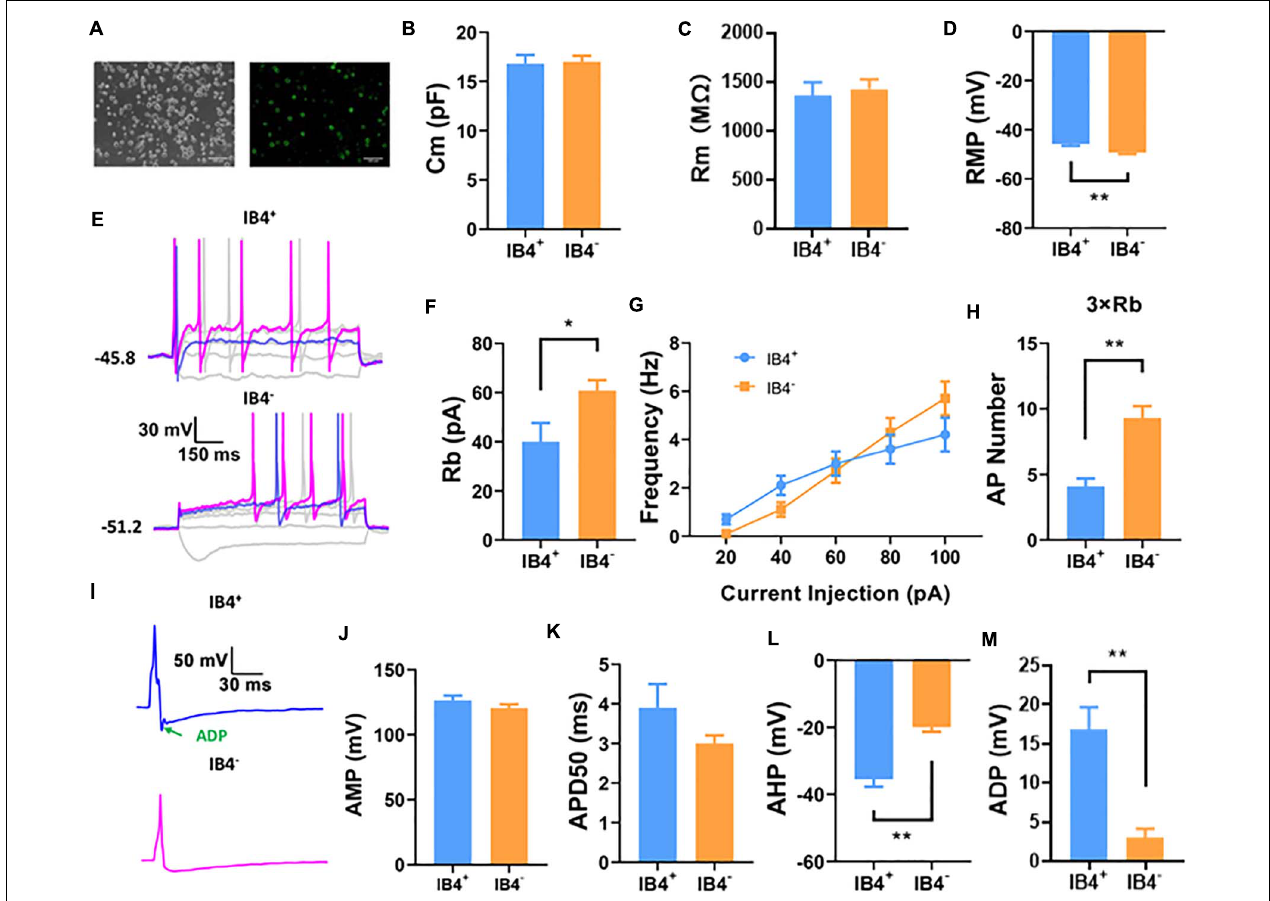
FIGURE 1 | Comparison of passive and active properties of IB4 + and IB4 − subpopulations of small DRG neurons in mouse. IB4 + and IB4 − subpopulations of small DRG neurons ( < 25 µ m), separated by the staining of IB4-FITC (A) . Small DRG neurons were recorded in current-clamp mode using a perforated configuration of whole-cell patch clamping. To avoid the confounding effects of IB4 staining on the forming of Giga-seal for patch clamp recording and potentially on the electrophysiological properties of DRG neurons, the DRG neurons were stained immediately after recording. Representative recordings using a long (1,000 ms) or short (5 ms) step current protocol were shown in (E,I) , respectively. Passive properties including membrane capacitance [Cm, (B) ], membrane resistance [Rm, (C) ], resting membrane potential [RMP, (D) ], and active properties including rheobase [Rb, (F) ], frequency (G) , number at 3x rheobase (H) , amplitude [AMP, (J) ], half duration [APD50, (K) ], afterhyperpolarization [AHP, (L) ], and afterdepolarization [ADP, (I,M) ] of action potentials were compared between IB4 + and IB4 − neurons. n = 17–38 for each groups (see detailed numbers for each group in results). *, P < 0.05; **, P < 0.01; Student’s t -test.